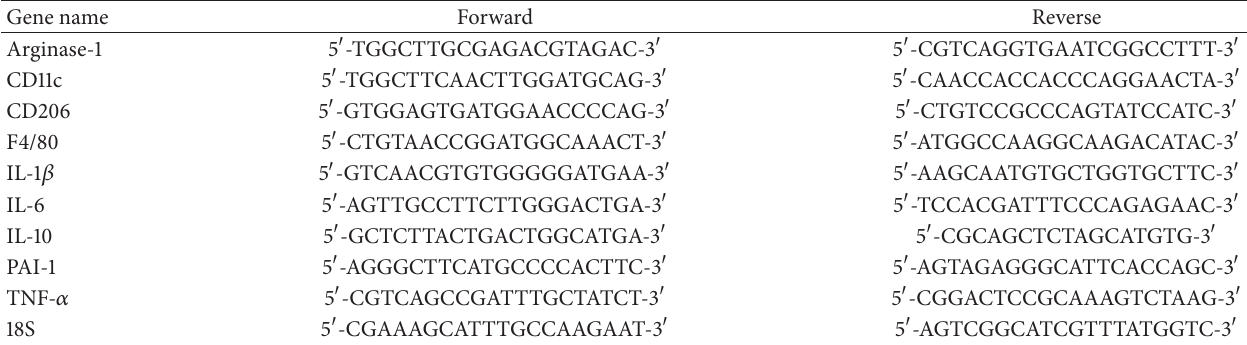
Table 1: Primer sequences of gene used in this